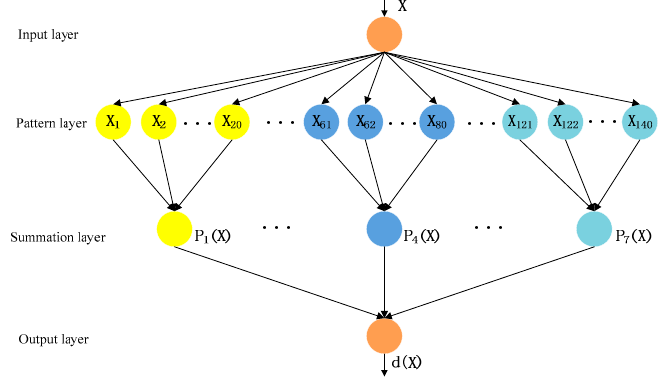
Figure 1. Structure of a probabilistic neural network (PNN) for hydrophobicity identification.